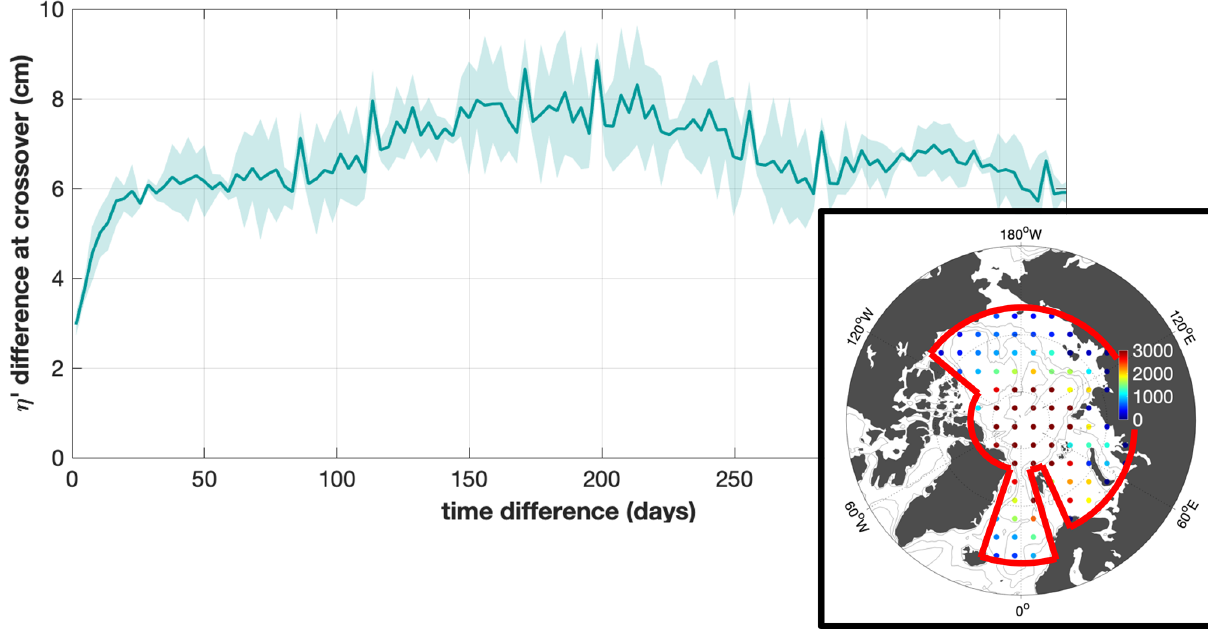
Figure 4. Absolute value of the η (cid:48) difference at crossovers between satellite tracks in a period of time of up to 1 year, computed using data inside the red line in the inset panel. The solid line in the main panel is the crossover difference averaged every 3d; the shaded area shows the standard deviation of the crossover difference, averaged every half a day. Crossover differences were computed using data within 100km around the locations indicated in the inset panel. The color of the dots in the inset panel indicates the number of crossovers found around that